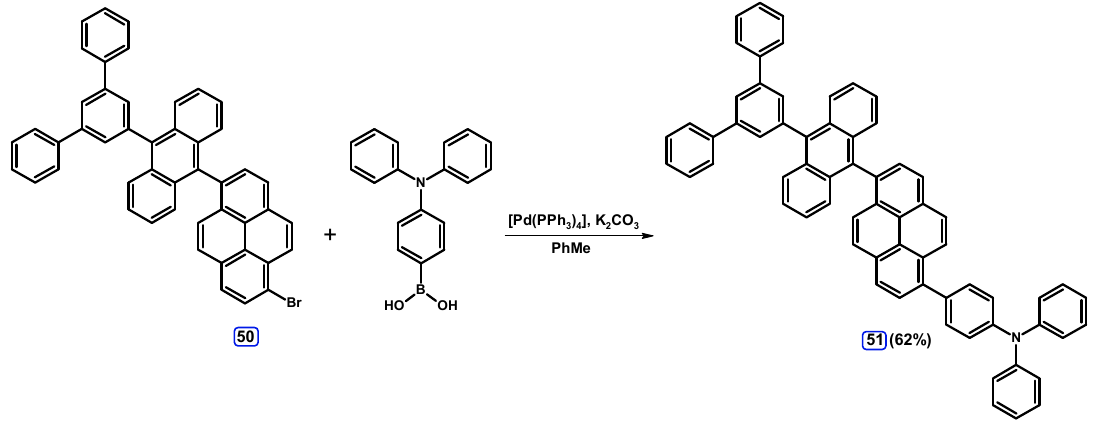
Scheme 31. Introduction of triphenylamine by using Suzuki-coupling reaction [60].